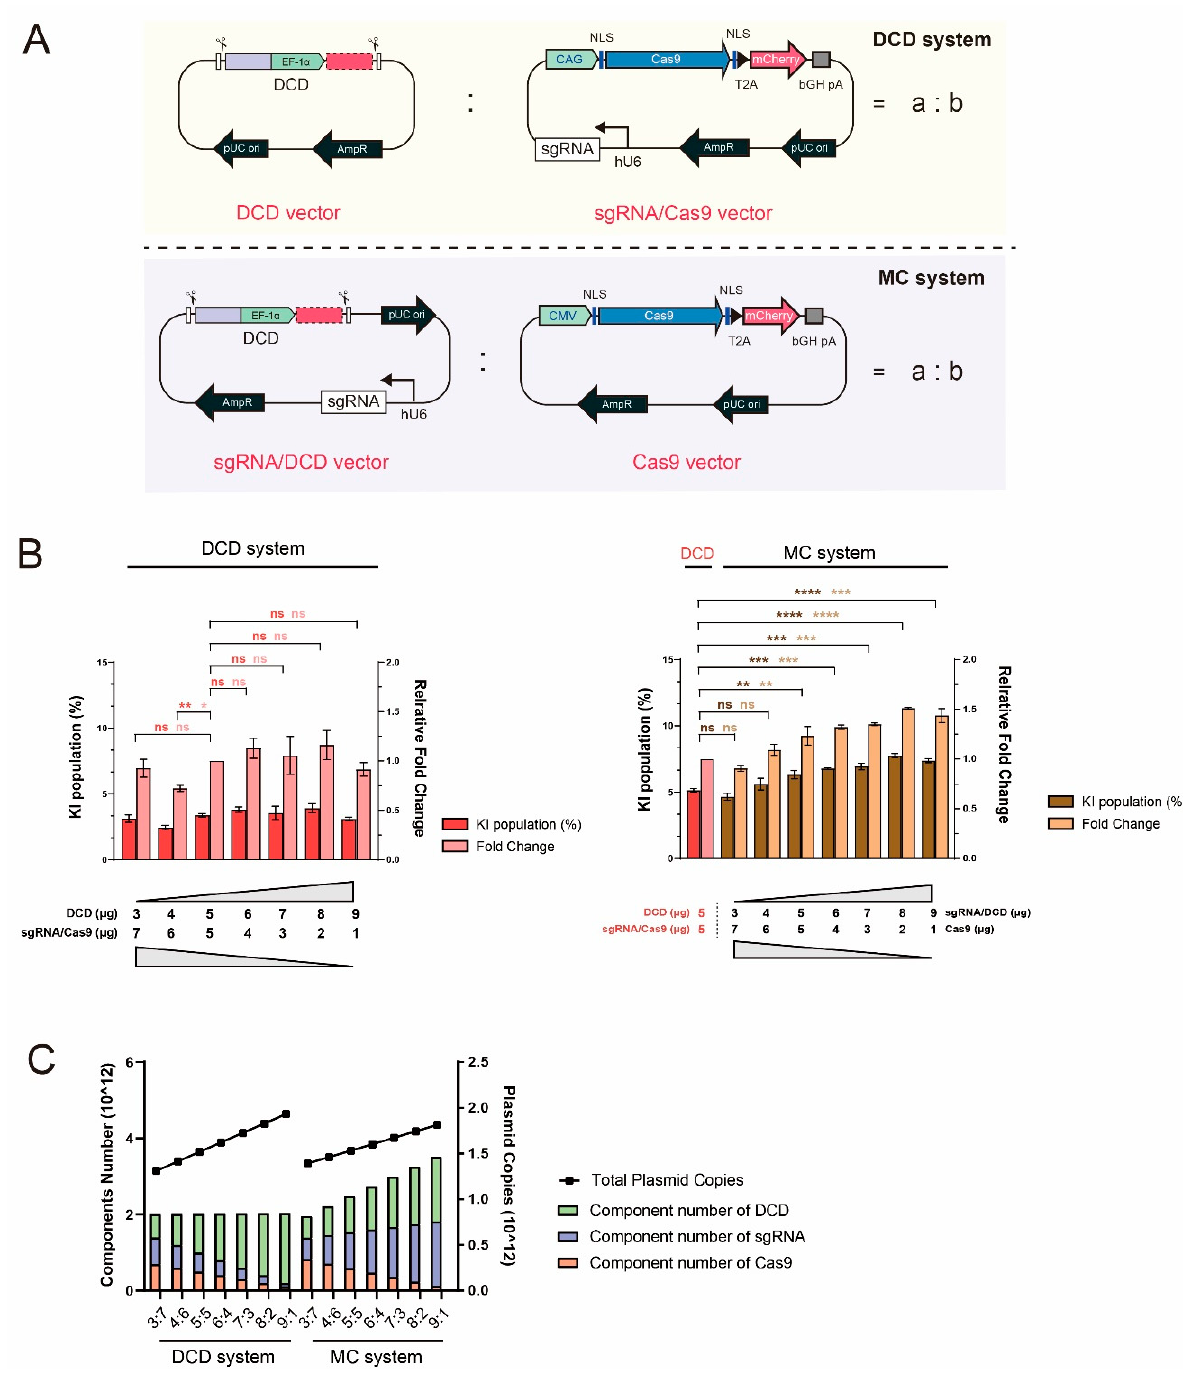
Figure 2. Enhancement of knock-in (KI) efficiency via multi-component (MC) system with optimized CRISPR component ratio. ( A ) Detailed schematic diagram of the vector construction of the DCD and MC systems. The main difference between the two systems is the location of the sgRNA expression cassette: either in the Cas9 vector (sgRNA/Cas9) or the DCD template (sgRNA/DCD) in the DCD and MC system, respectively. In the case of the sgRNA/DCD vector, the ampicillin resistance gene and origin of replication separate the DCD template and sgRNA expression cassette at a distance. ( B ) Evaluation of the KI efficiency of different ratios of CRISPR-HDR components in DCD (left) and MC systems (right). Seven different ratios (w/w) from 3:7 to 9:1 were tested in both systems, as indicated in a:b (A). The previous DCD 5:5 (w/w) system was set as a relative control in both systems. The error bars represent the mean ± standard deviation from two or three independent experiments. n = 3 for the DCD system and n = 2 for the MC system, *p ≤ 0.05, **p ≤ 0.01, ***p ≤ 0.001, **** p ≤ 0.0001; ns, not significant. ( C ) Calculation of plasmid copies and the number of CRISPR–HDR components tested in (B).